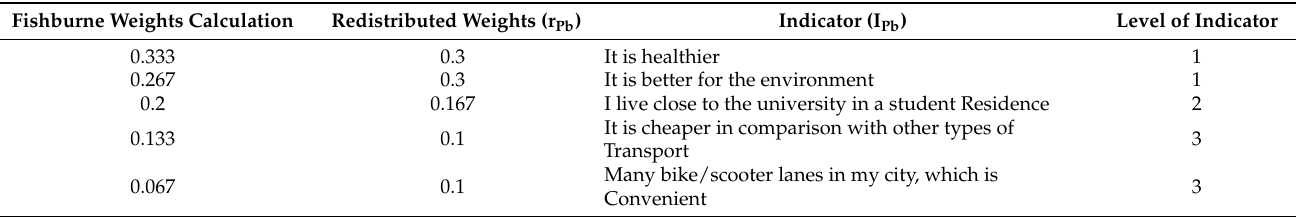
Table 22. Reasoning indicators for private bicycle/electric